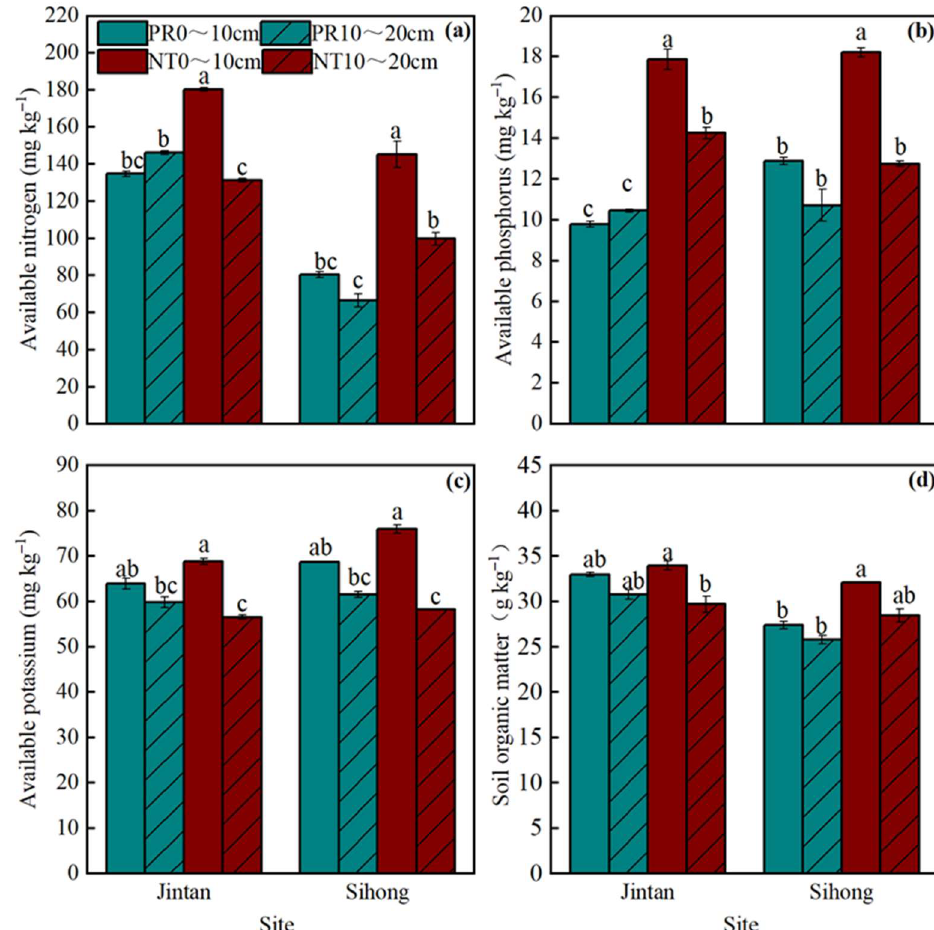
Figure 6. Effects of tillage methods on the content of available nitrogen ( a ), available phosphorus ( b ), available potassium ( c ), and soil organic matter ( d ) in 0–10 cm and 10–20 cm soil at Jintan and Sihong in 2018–2019. Tillage methods included plow tillage followed by rotary tillage (PR) and no-tillage (NT). All values are presented as mean ± SE (3 replicates) with one standard error. Bars labeled with different letters indicate significant differences at the p < 0.05 level.